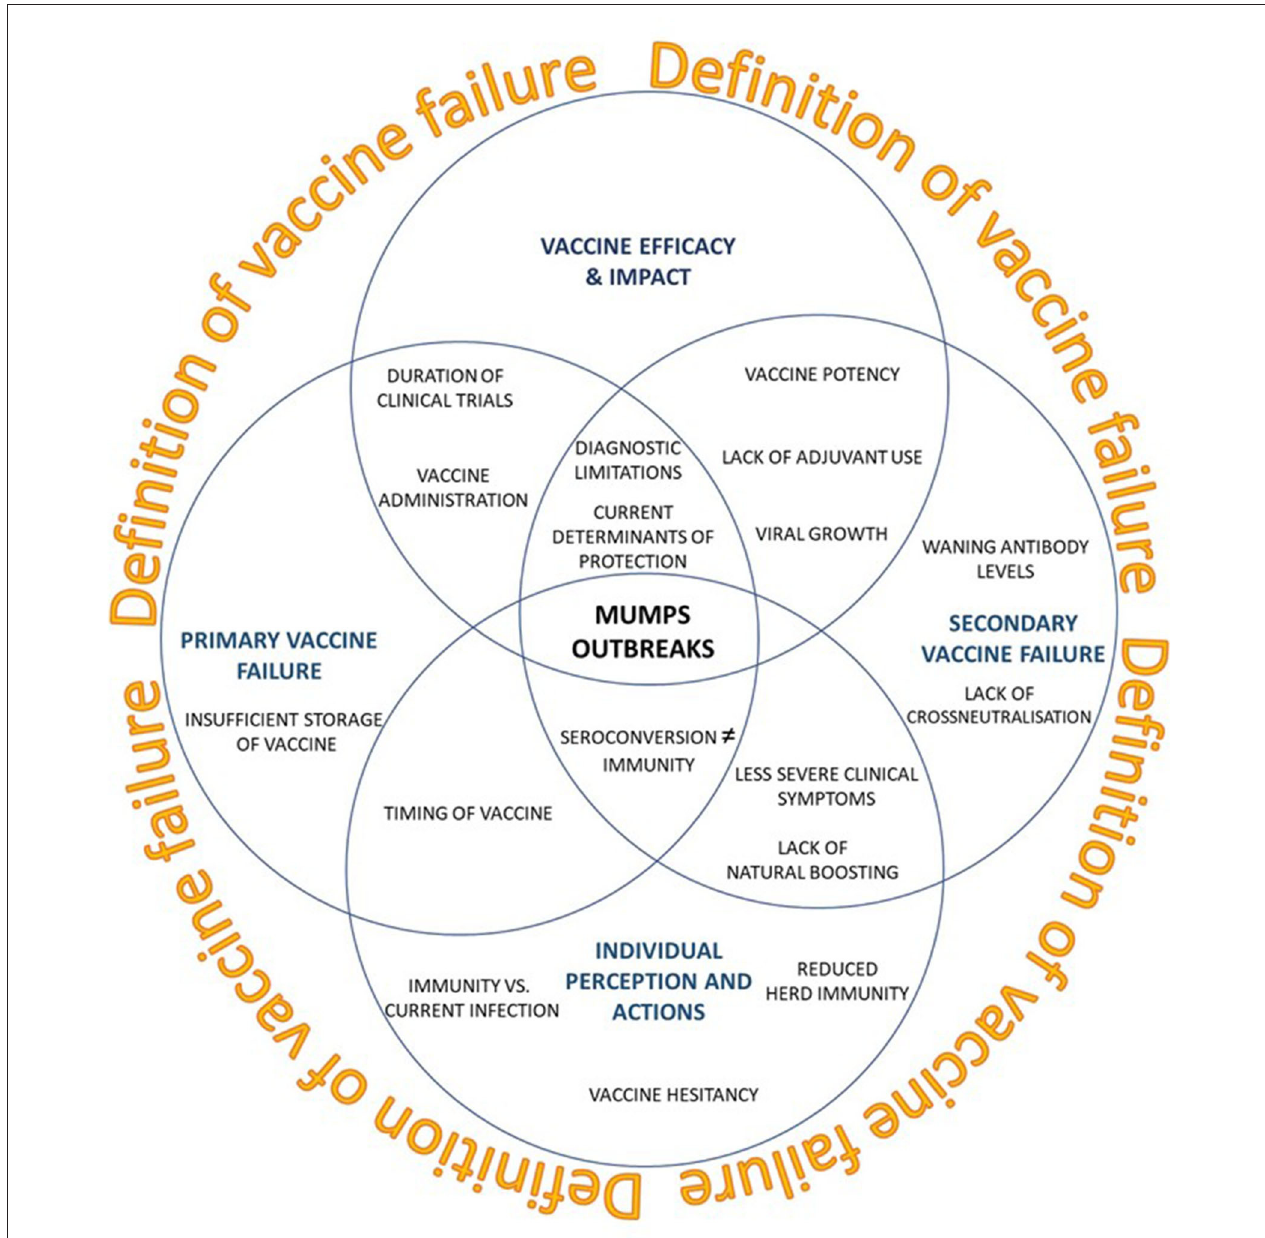
FIGURE 1 | Current perspectives on recent mumps outbreaks seen in vaccinated populations (blue circles). How impactful a vaccine is defined may lead to a paradigm shift in what constitutes an effective vaccine.